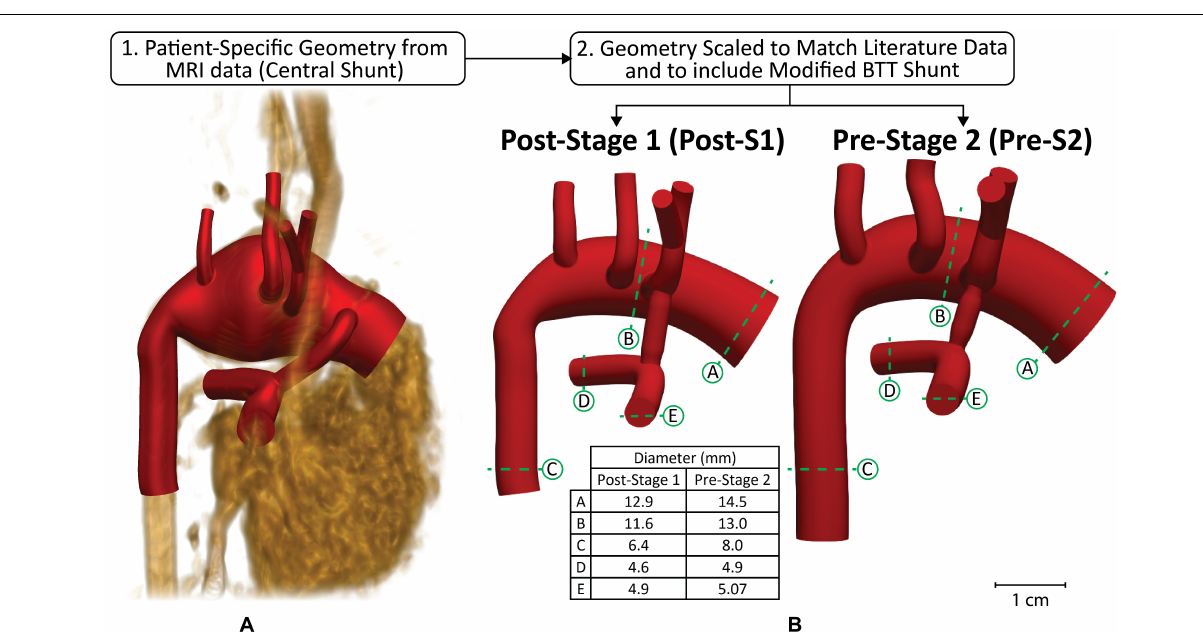
FIGURE 2 | Modeling approach used to reconstruct anatomy of representative HLHS patient geometry at two time-points–post-S1 and pre-S2. Anatomy was constructed from (A) patient-specific MRI data that was then (B) scaled to match literature-based morphological data for both time-points (Machii and Becker,